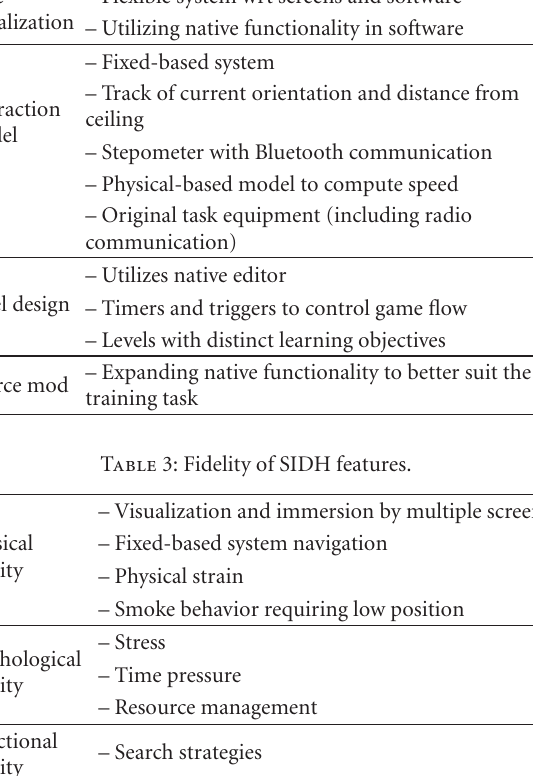
Table 2: Architectural features of SIDH. Cave